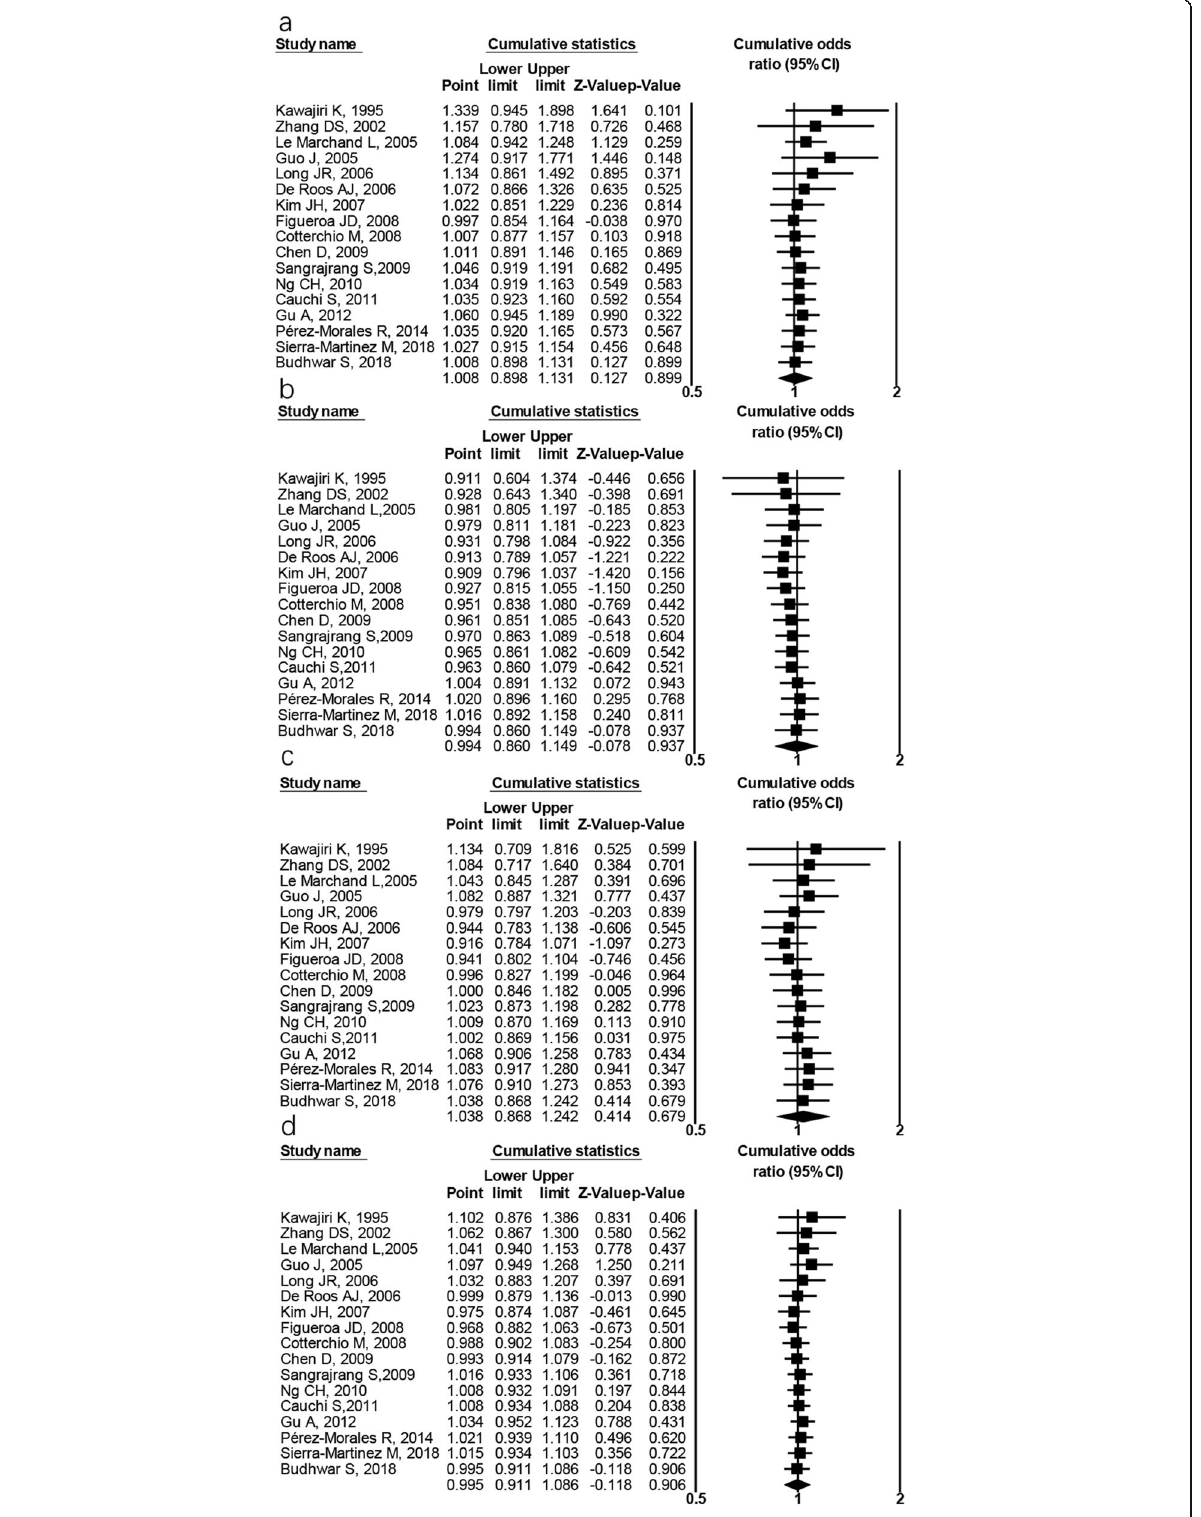
Fig 6 Cumulative meta-analysis for AhR rs2066853 polymorphism and the overall cancer risk according to publication year. a Dominant model (AA+GA vs. GG), b recessive model (AA vs. GA+GG), c codominant model (AA vs. GG), and d allelic model (A vs.